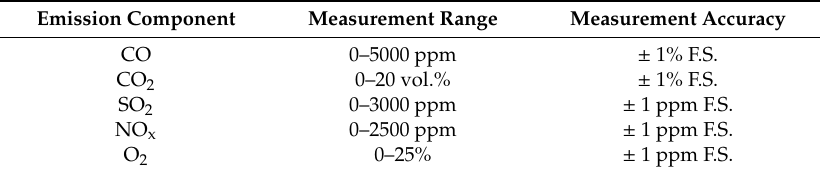
Table 3. Measurement range and resolution of HORIBA PG-250 analyser.